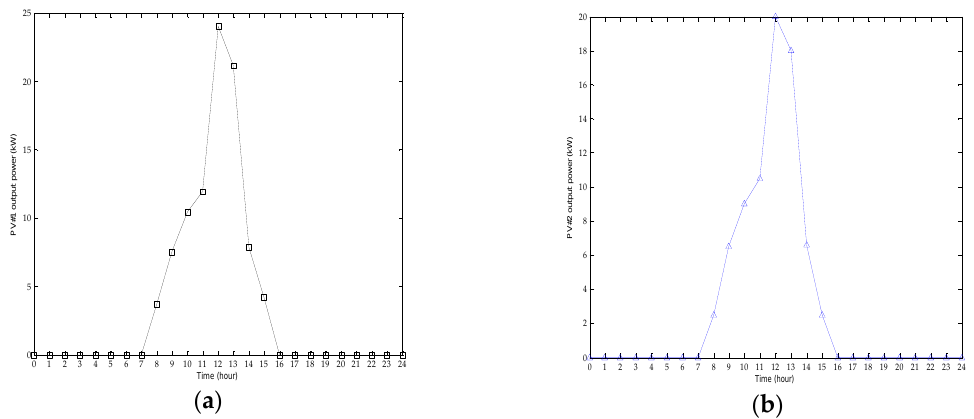
Figure 7. Power output of photovoltaic in a single day. ( a ) PV output of ERC1 in a day; ( b ) PV output of ERC2 in a day.